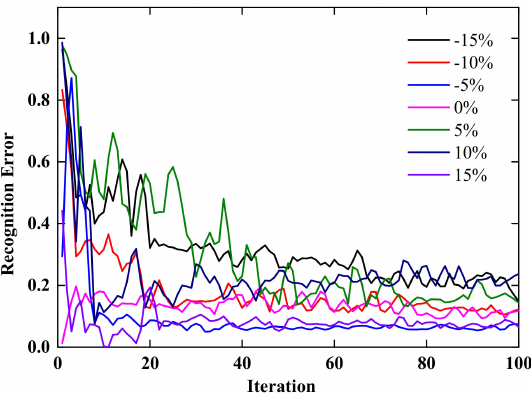
Figure 9. Training curves of the BP neural network for 7 slopes.